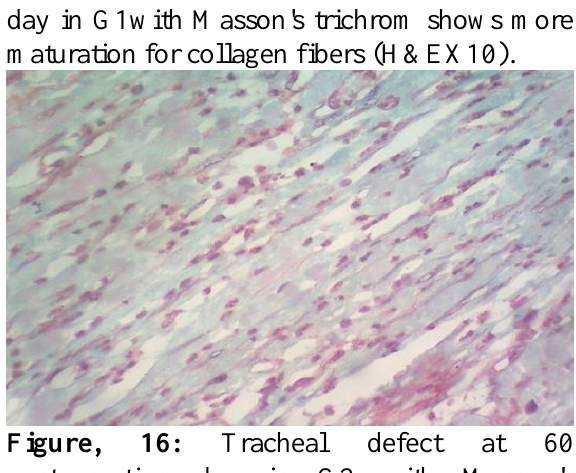
Figure, 16: Tracheal defect at 60 postoperative day in G2 with Masson's trichrom shows increases in maturation of collagen fibers